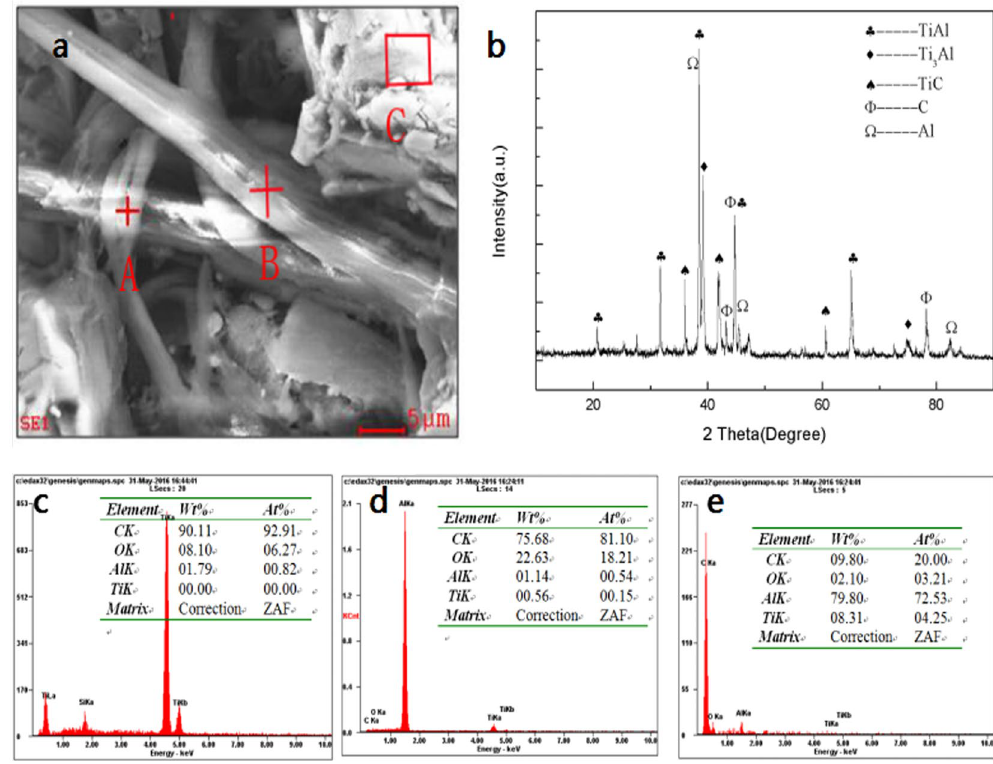
Figure 1. Microstructure and EDS patterns of carbon fibers coated with graphene reinforced TiAl alloys composite bulks. ( a ) SEM image and ( b ) XRD pattern, ( c ) EDS patterns of short rob in the marked area A, ( d ) EDS patterns of short rob in the marked area B and ( e ) EDS patterns of short rob in the marked area C of carbon fibers with graphene coating reinforced TiAl composite bulk (CFGCRTAC) sintered at 620 °C for 10